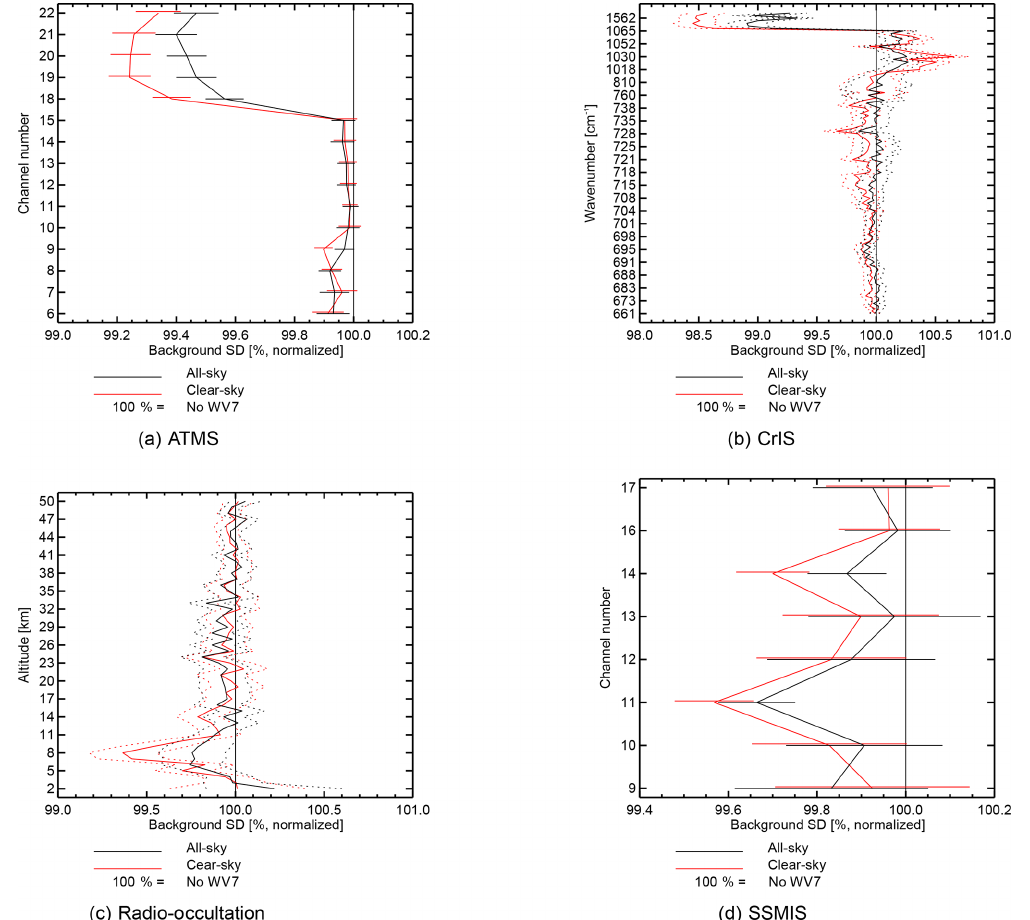
Figure 14. Global standard deviation of bias-corrected background departures computed between the 12h forecast and a selection of as- similated observations with mostly humidity and temperature sensitivity: (a) temperature and humidity sounder ATMS, (b) hyperspectral IR sounder CrIS, (c) radio occultation, and (d) All-sky microwave imager and sounder SSMIS. The 95% confidence interval is represented either by error bars or dotted lines. Results are computed over the combined 6-month experimental